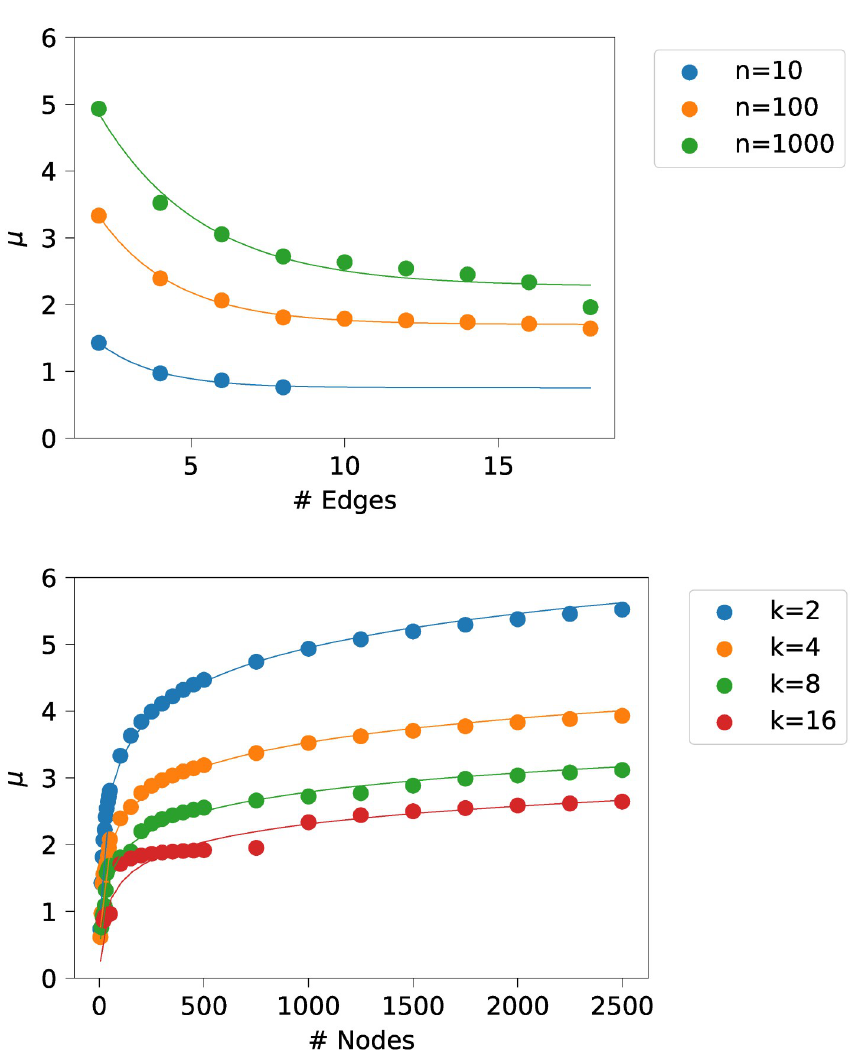
Fig 5. Datapoints for various graph sizes split by number of edges per node k and number of nodes n . μ estimate for the number of edges per node and fitted using log( n ) for the number of nodes dimension. fitted using 1 e k